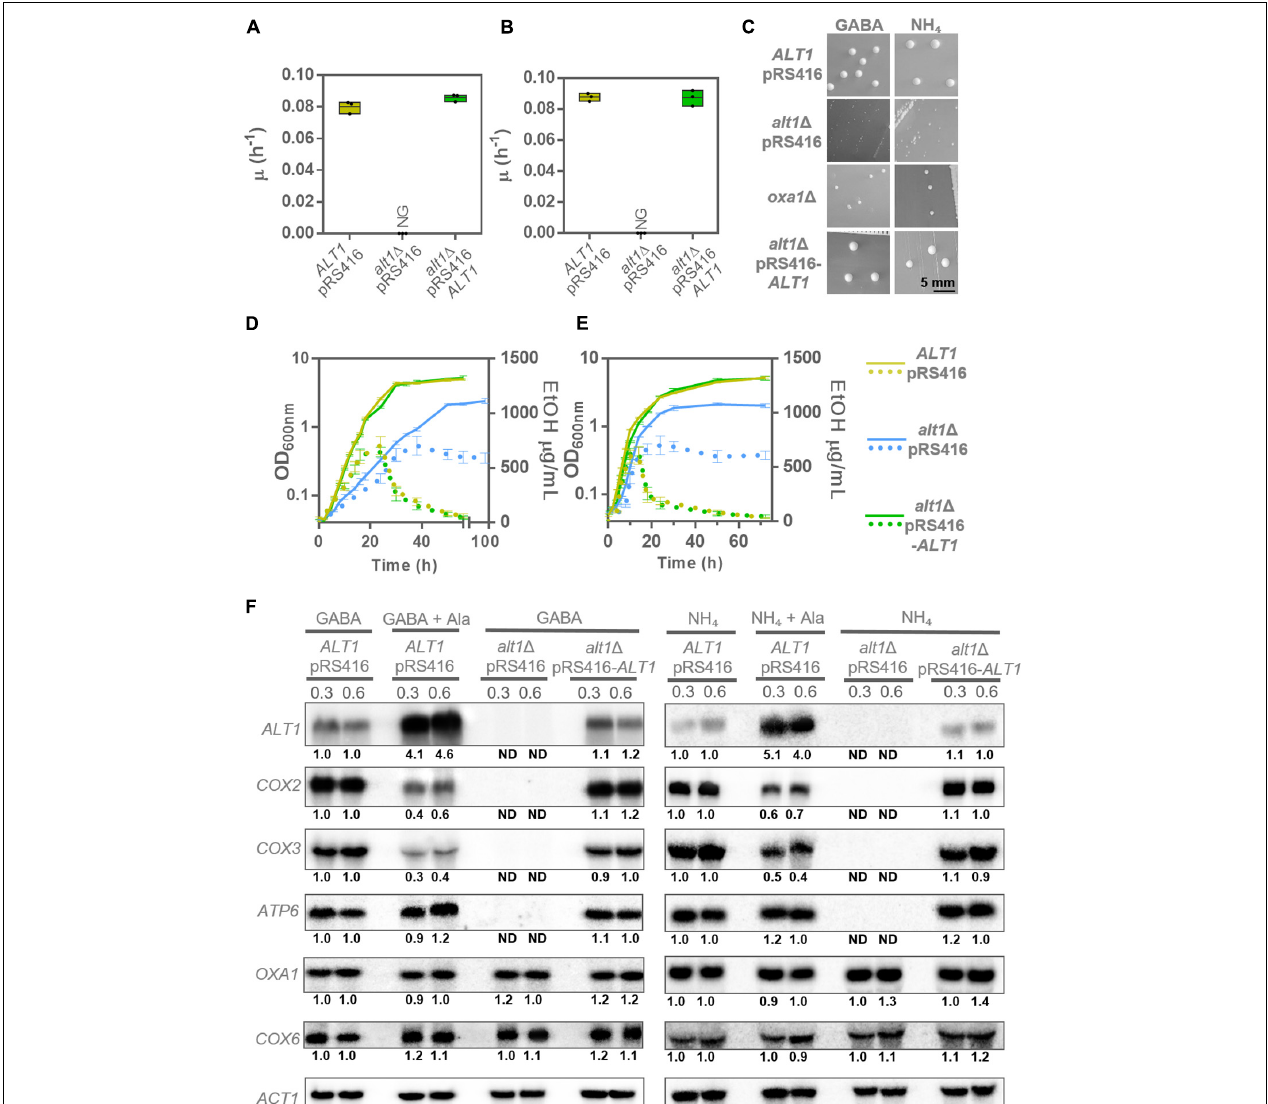
FIGURE 5 | alt1 (cid:49) mutant shows petite phenotype and severely decreased expression of various mitochondrial genes. (A) Specific growth rate in ethanol GABA. (B) Specific growth rate in ethanol ammonium. Boxes show individual values (points) and the average (middle line) ± SE of three independent experiments. (C) Colony size in glucose + GABA (GABA) and glucose + ammonium (NH 4 ). To obtain colony size, plates were incubated at 30 ◦ C during 4 days in the case of glucose GABA (GABA) and 3 days in the case of glucose ammonium (NH 4 ). (D) Cells were cultured to monitor biomass (solid lines) and ethanol concentration (dotted lines) in glucose + GABA. Each line represents the average ± SE of three independent experiments. (E) Cells were cultured to monitor biomass (solid lines) and ethanol concentration (dotted lines) in glucose + ammonium. Each line represents the average ± SE of three independent experiments. (F) Northern blot in glucose + GABA (GABA) and glucose + ammonium (NH 4 ) to determine the expression of mitochondrial genes ( COX2 , COX3 , and ATP6 ) in the presence of alanine (+Ala) and in the alt1 (cid:49) mutant at OD 600 nm = 0.3 and 0.6. Alanine was added to observe the effect on the mitochondrial gene expression. COX6 and OXA1 are nuclear genes and were tested to determine any possible effect of alanine addition or ALT1 absence. Numbers below the blots represent the fold change with respect to the ALT1 pRS416 strain grown in GABA or ammonium (rows 1 and 2 of each Northern assay) after quantification and normalization relative to ACT1 . Abbreviations: NG, no growth; ND, not